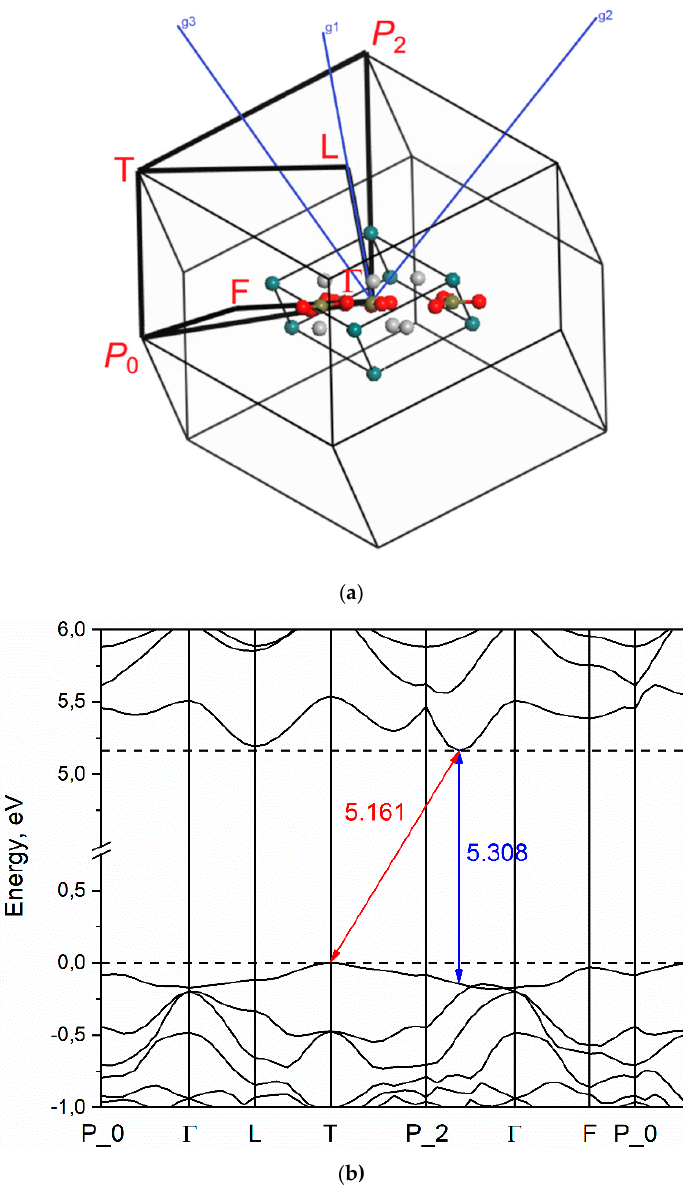
Figure 3. Brillouin zone of the YAl 3 (BO 3 ) 4 rhombohedral lattice ( a ) and electronic band structure ( b ).